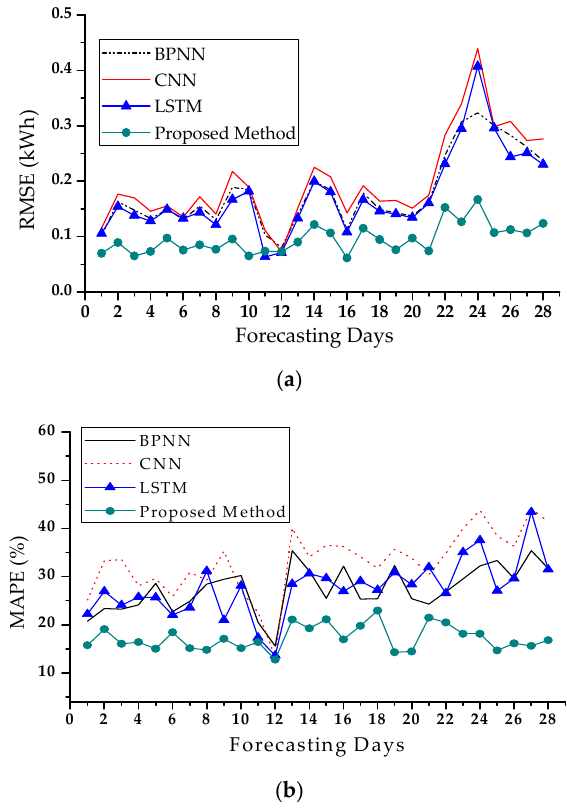
Figure 8. Average mean absolute percentage error (MAPE) and root mean square error (RMSE) of ten arbitrary selected households in July: ( a ) MAPE result, and ( b ) RMSE result.